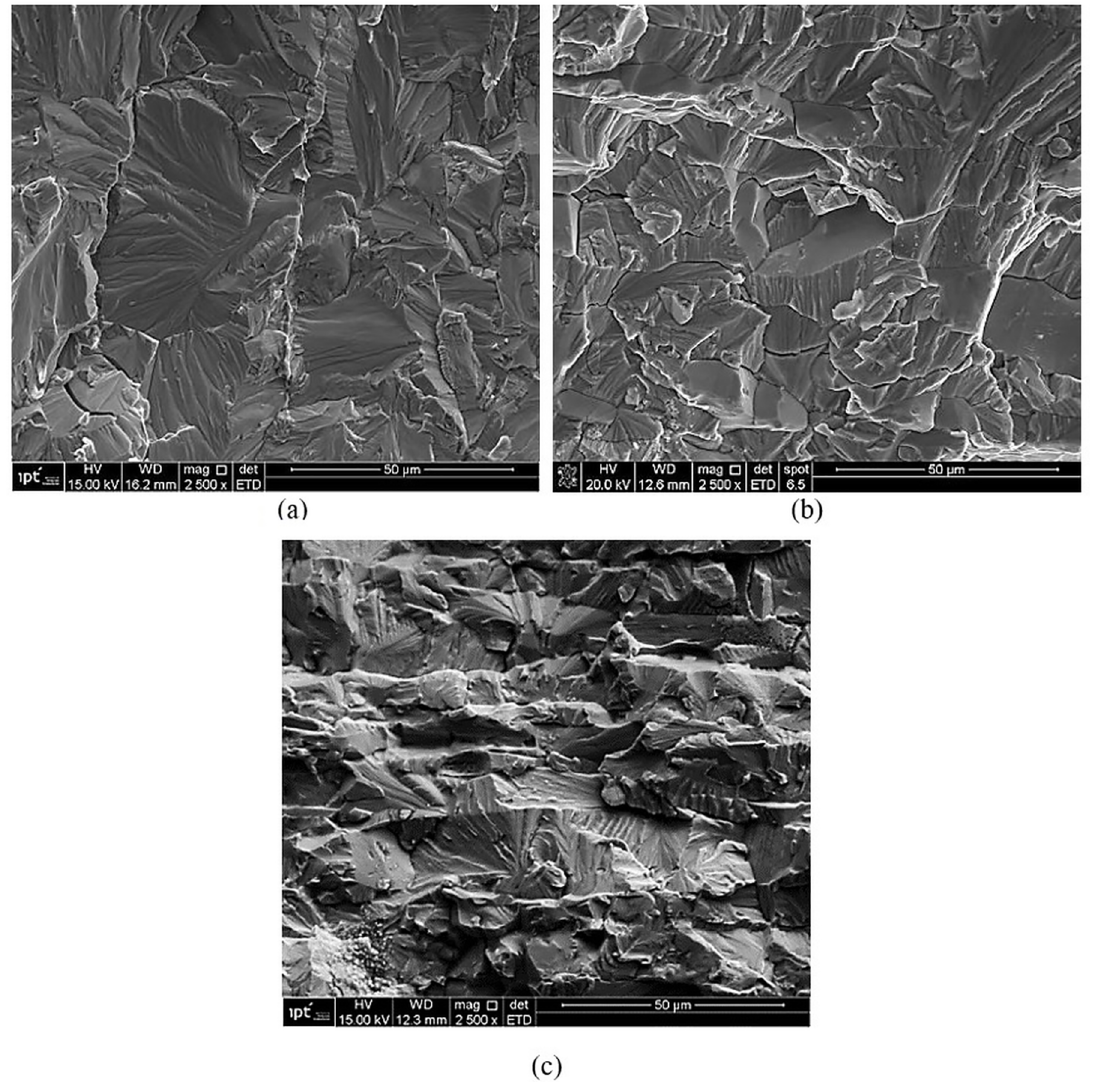
Figure 11. Microfractographic examination of the exposed surface of the cracks after DET at 110 °C. (a) UNS S31603 ASS tested at 100 % of the yield stress (278 MPa); (b) UNS S32205 DSS tested at 100 % of the yield stress (473 MPa); (c) UNS S32750 SDSS tested at 100 % of the yield stress (589 MPa).